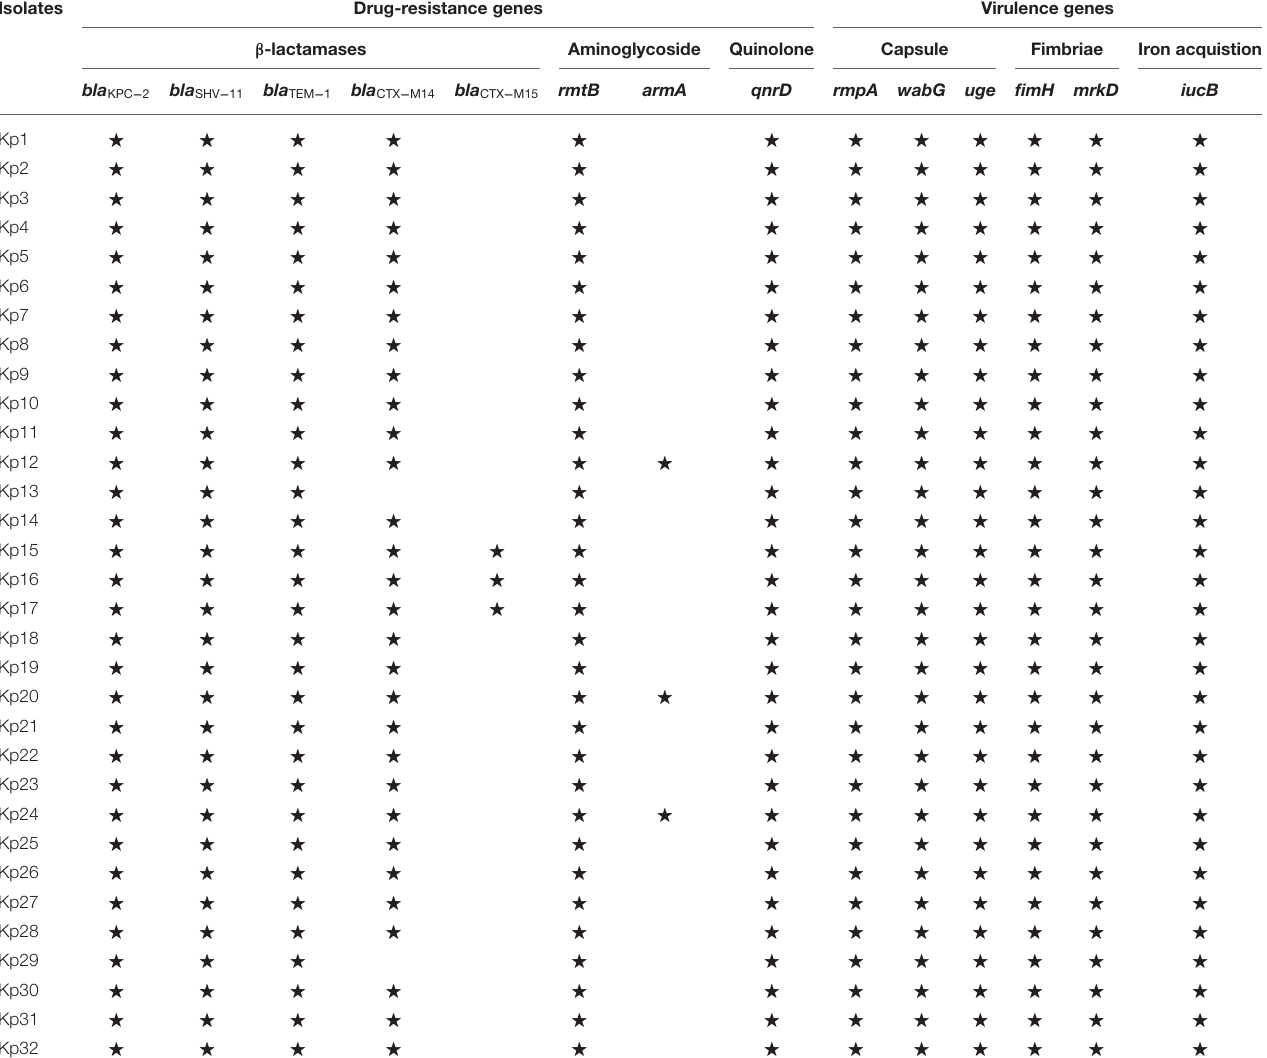
TABLE 2 | The drug-resistance genes and virulence genes of 32 CR-hvKP.